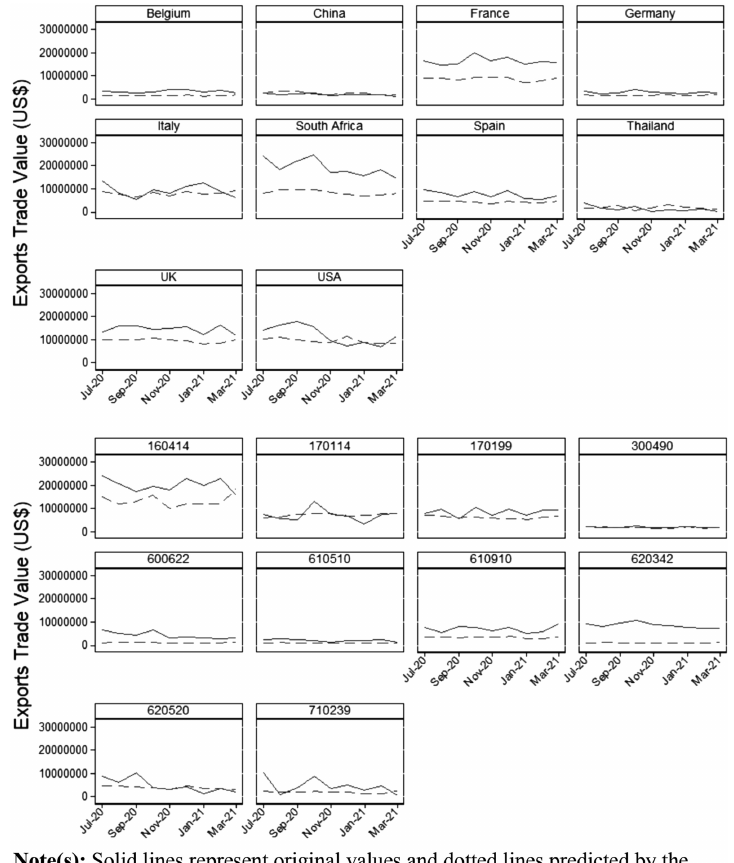
Figure 2. Predicted and